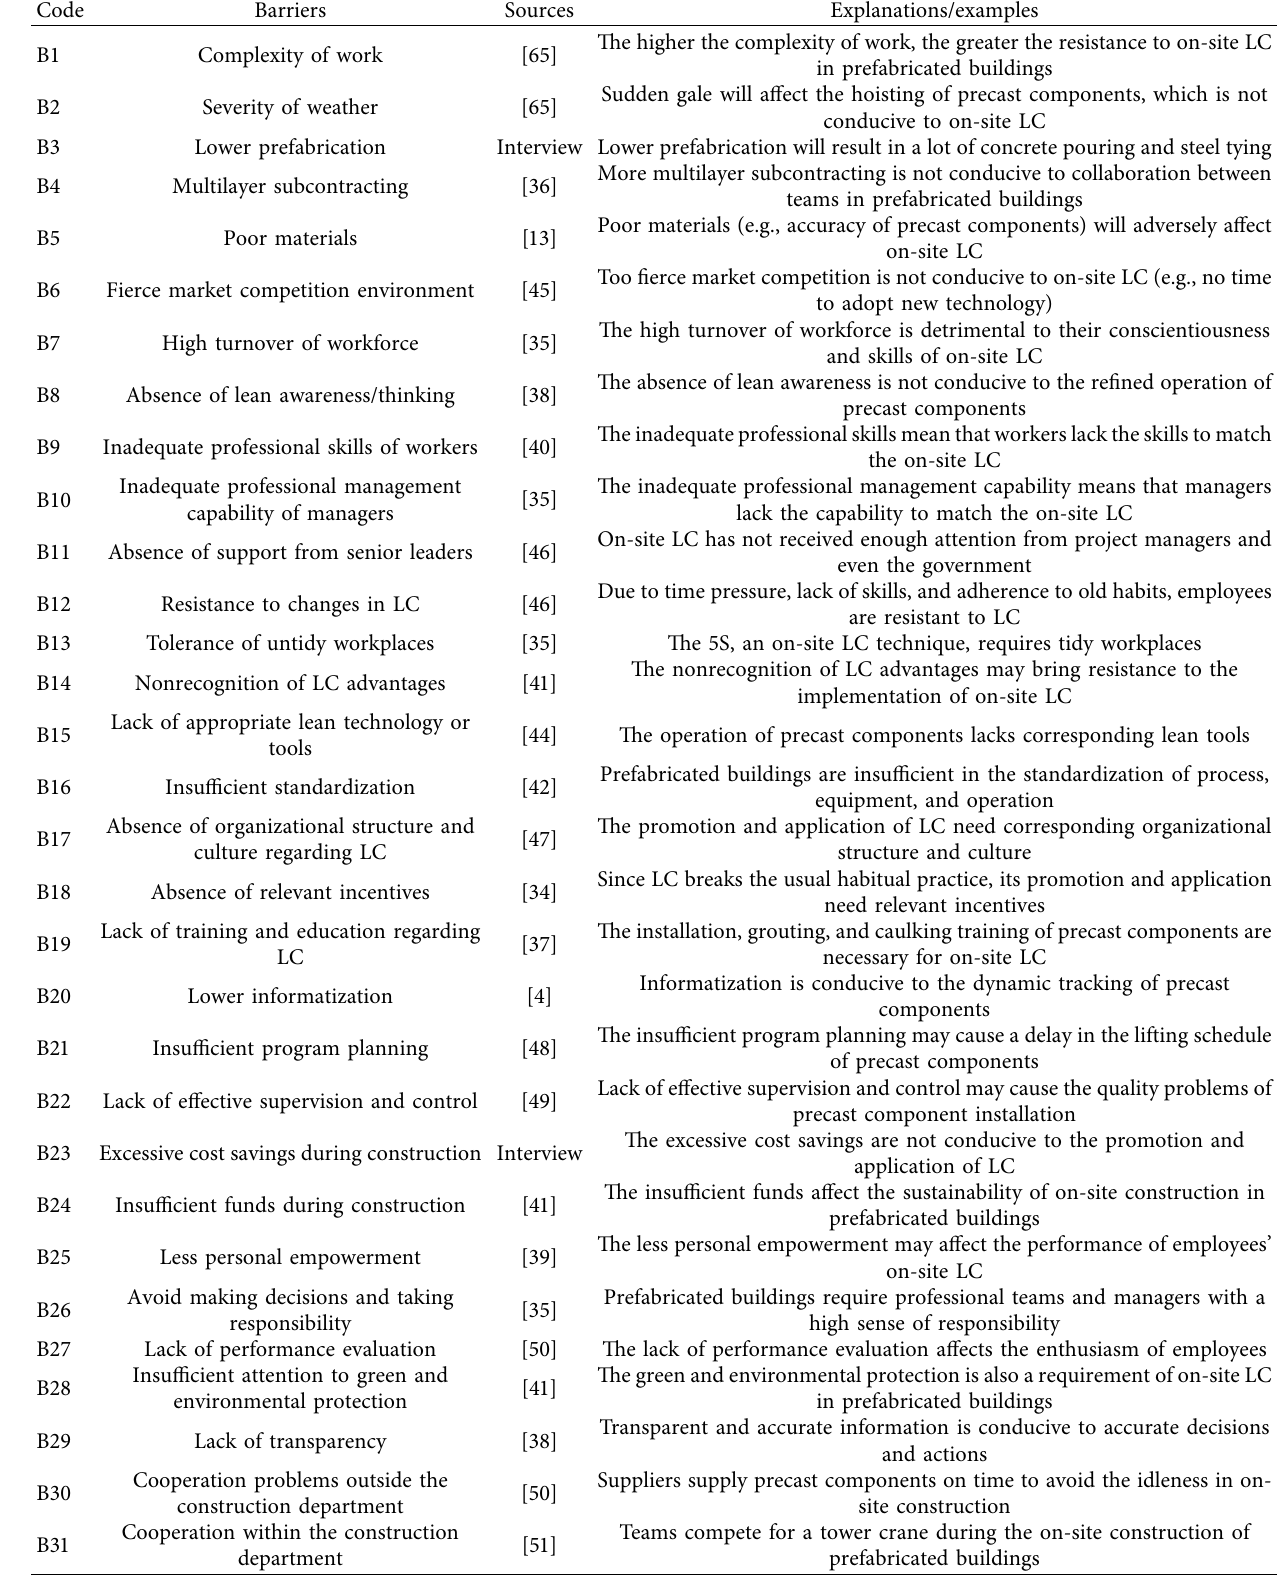
Table 3: Barriers to on-site lean construction (LC) for prefabricated